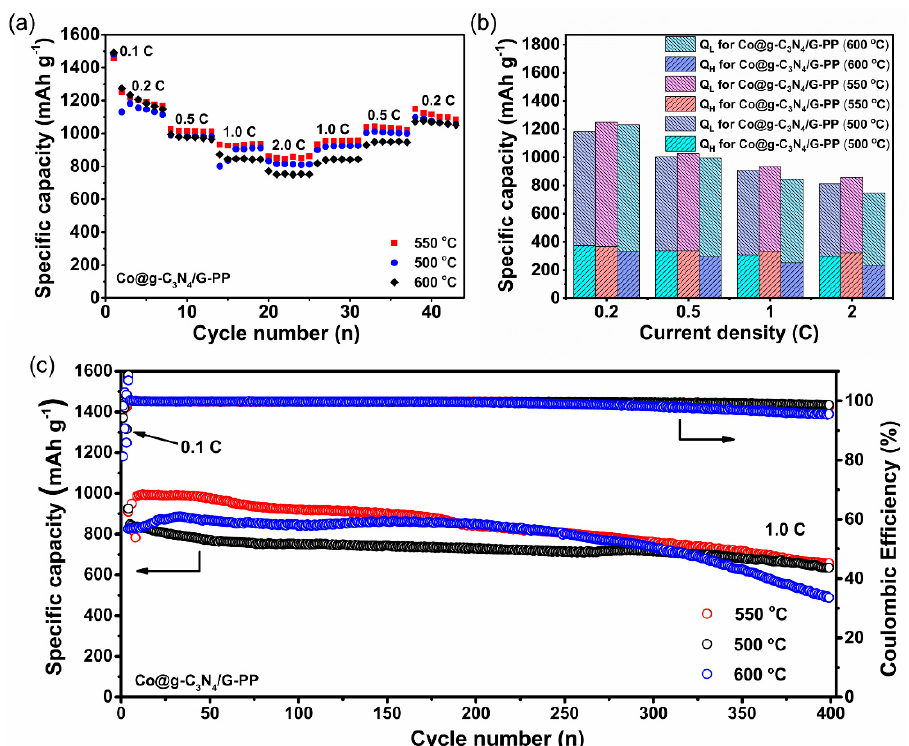
Figure 5. ( a ) Rate performances, ( b ) change in the high-plateau capacity and low-plateau capacity, and ( c ) long cycling performances of Li-S cells with the corresponding Co@g-C 3 N 4 /G-PP